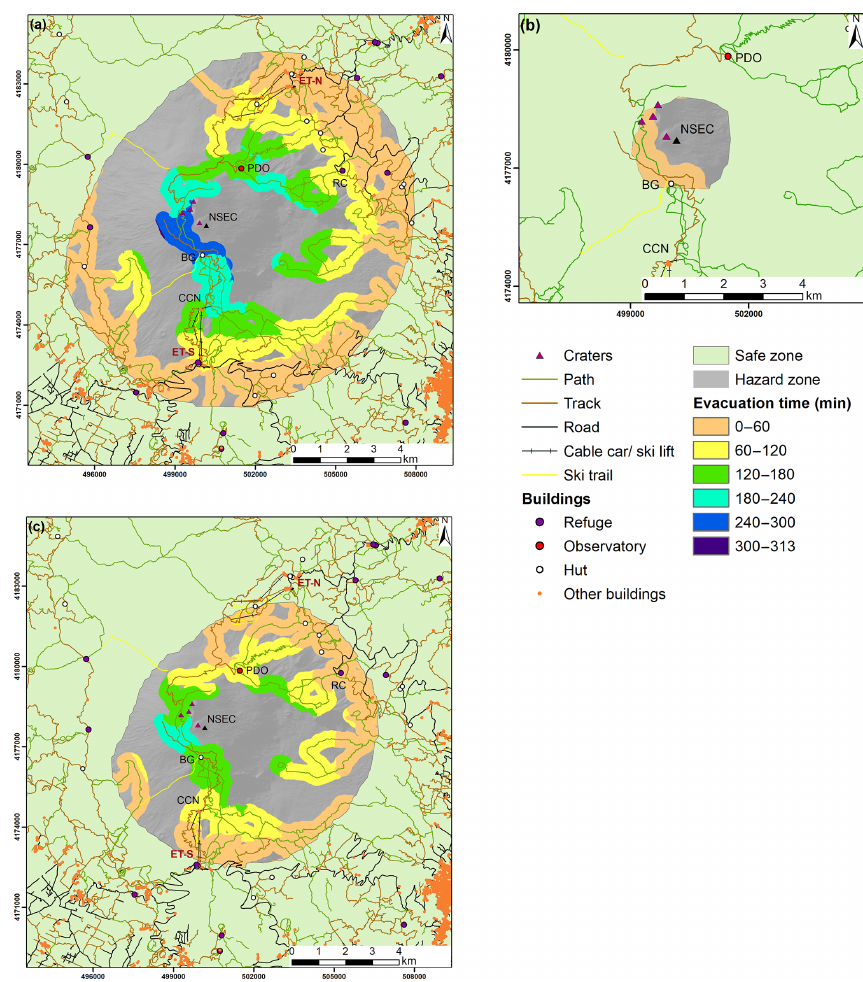
Figure 4. Evacuation times to reach the safe zone based on walking speed of 3.3kmh − 1 , assuming people start a maximum of 300m from any path for (a) OES–HMER, (b) OES–LMER, (c) ERS. The hazard zone is the area with a probability of impact from 5cm clast ≥ 1%. The safe zone includes areas with a probability of impact < 1%. NSEC: New Southeast Crater. Ski areas: ET-N: Etna Nord; ET-S: Etna